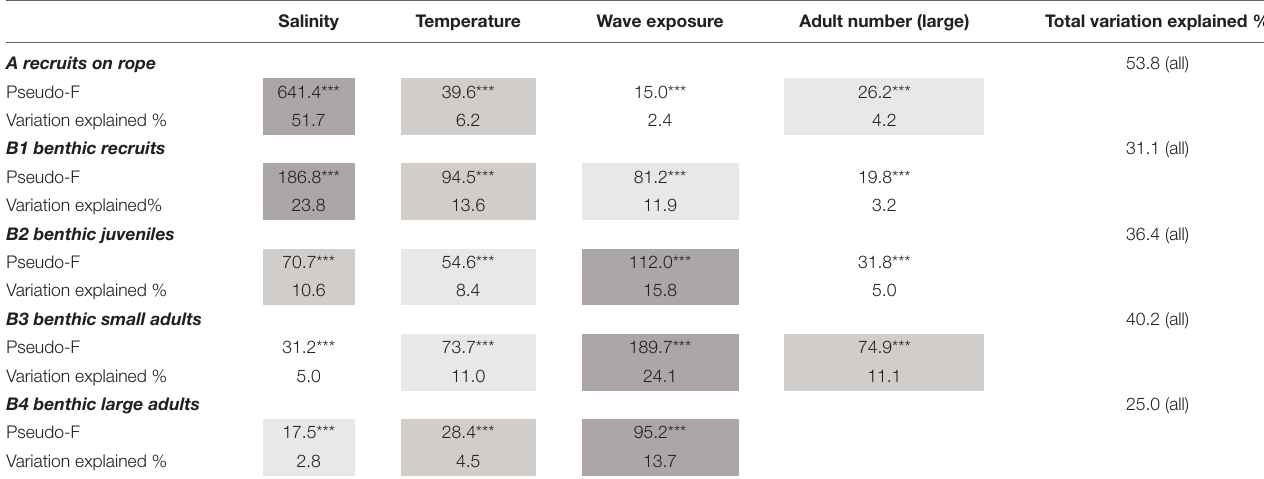
TABLE 1 | Relationship between number of mussels within different groups and registered environmental variables according to five